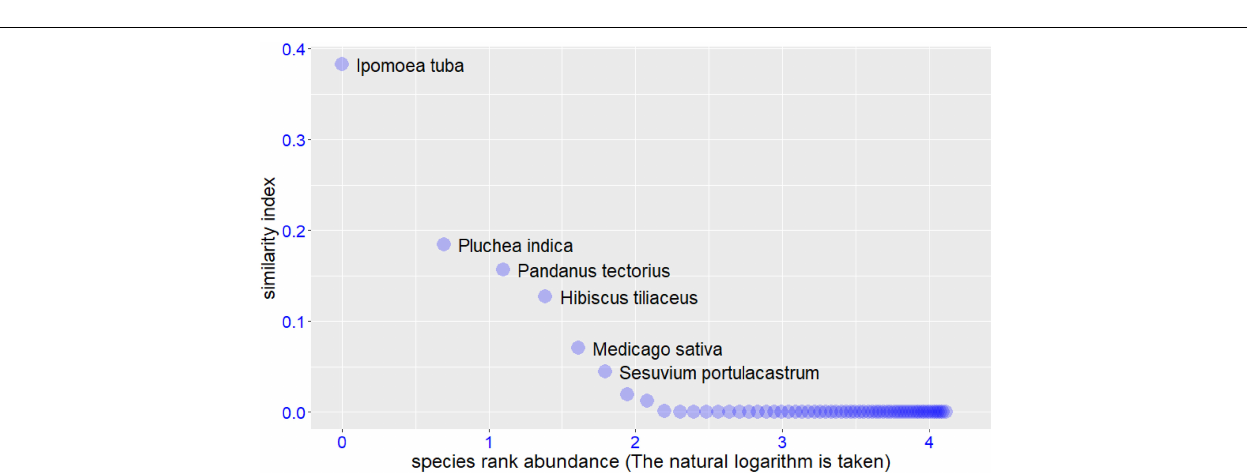
FIGURE 3 | Similar to figure 2, but the species selection results for the target species Ipomoea pes-caprae .